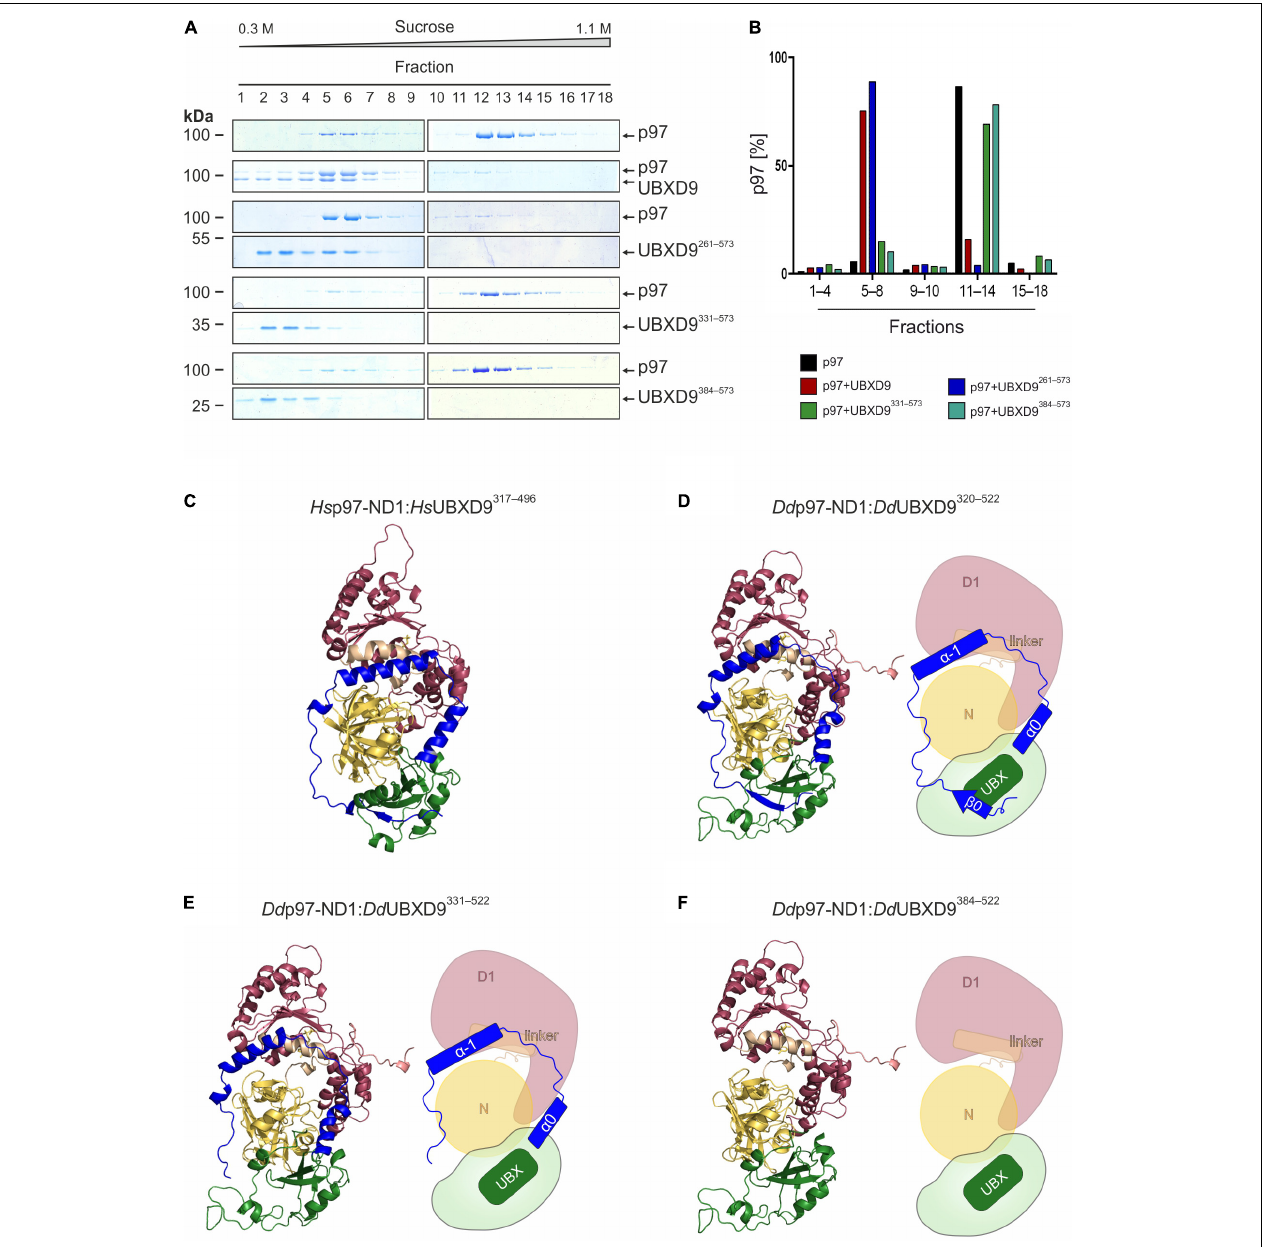
FIGURE 4 | The helical lariat structure of UBXD9 is pivotal for its disassembly activity. (A) Sucrose density gradient sedimentation with p97 alone (top panel) or with equimolar amounts of p97 and full-length UBXD9 (2nd panel from top) or p97 and UBXD9 261 − 573 (3rd and 4th panels from top), or p97 and UBXD9 331 − 573 (5th and 6th panels from top), or p97 and UBXD9 384 − 573 (lower two panels). Before loading the samples on the sucrose density gradient (0.3–1.1 M sucrose), they were incubated with 1 mM ATP for 30 min. Fractions were removed consecutively after centrifugation and analyzed by SDS-PAGE and Coomassie Brilliant Blue staining. p97 monomers or dimers are present in fractions 5–8 and p97 hexamers in fractions 11–14. Fractions are numbered, starting with #1 at 0.3 M sucrose. The positions of p97, full-length UBXD9 and UBXD9 truncation constructs are indicated. (B) Bar graphs depicting the quantification of p97 in fractions 1–4, 5–8, 9–10, 11–14, and 15–18 of the different experiments. The bar graphs represent mean values of at least three independent experiments. The determined total amount of p97 in all 18 fractions was set to 100%. (C) Structural model of the Hs p97-ND1:Hs UBXD9 317 − 496 (VCP:ASPL; PDB: 5ifs) complex. UBXD9 317 − 496 is shown in green and ochre and the ND1 domains of p97 (VCP) are colored yellow and dark pink, respectively. The region N-terminal of the UBX domain forms a loop, which encompasses two α -helices ( α - 1 and α 0 ; blue), an extended linker (blue) and a β -strand ( β 0 , blue). The α -helices and the linker embrace the N domain of p97 and the β 0 -strand appears to be crucial for the closure of the lariat structure. The helical lariat probably interferes with the D1:D1’ inter-monomeric interaction of the p97 hexamer, causing its disassembly (Arumughan et al., 2016; Banchenko et al., 2019). (D–F) Homology models and schematic representation of the D. discoideum p97-ND1:UBXD9 320 − 522 (D) , p97-ND1:UBXD9 331 − 522 (E) , and p97-ND1:UBXD9 384 − 522 (F) complexes representing our truncation constructs UBXD9 261 − 573 , UBXD9 331 − 573 , and UBXD9 384 − 573 , respectively. Since our modeling was based on the Hs- p97-ND1: Hs- UBXD9 317 − 496 (VCP:ASPL; PDB: 5ifs) complex, the structural models could only be generated from amino acids 320–522 of D. discoideum UBXD9.